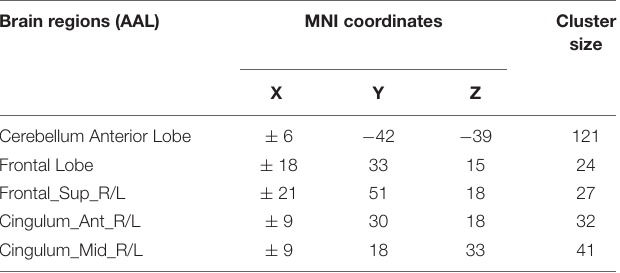
TABLE 2 | Brain regions showing significant differences in VMHC between the TLE and HC groups. Brain regions